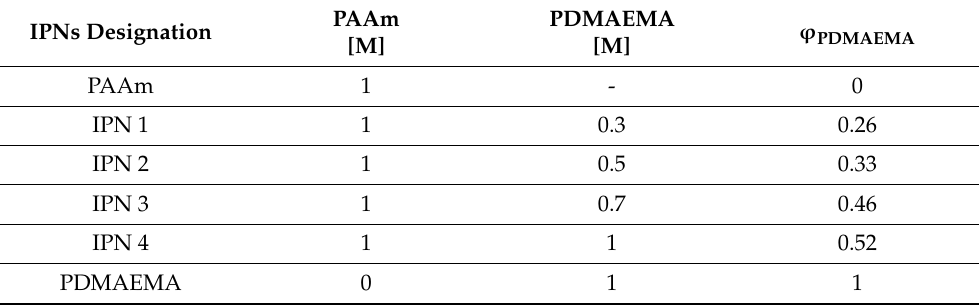
Table 3. Composition of the synthesized PDMAEMA/PAAm IPNs expressed by the molar part of PDMAEMA in the obtained IPNs ( ϕ PDMAEMA